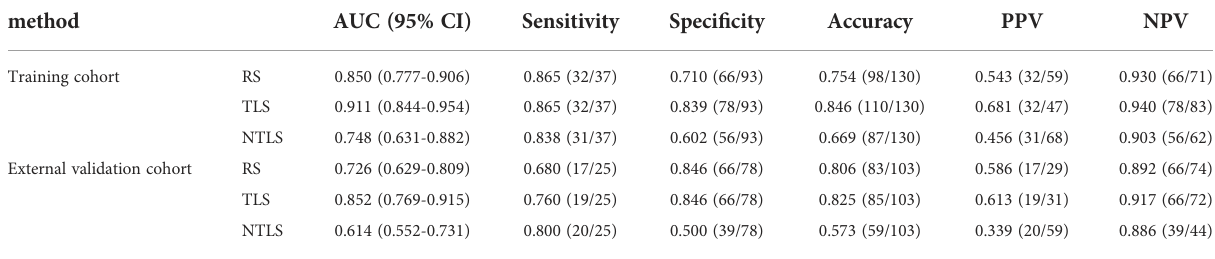
TABLE 2 A performance summary of RS, NTLS and TLS in the training and validation cohorts for preoperative identi fi cation of lymphovascular invasion status in patients with invasive breast cancer.